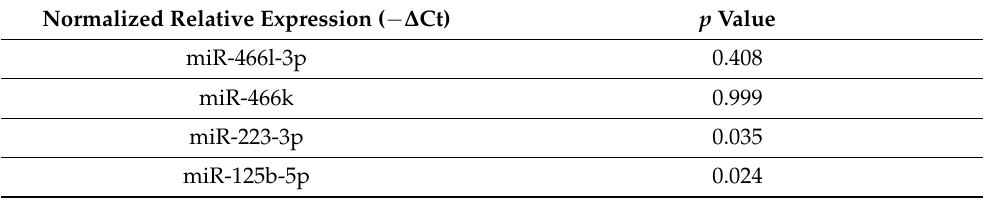
Table 4. Kruskal–Wallis test for the normalized relative expression of the four microRNAs along mast cell count.